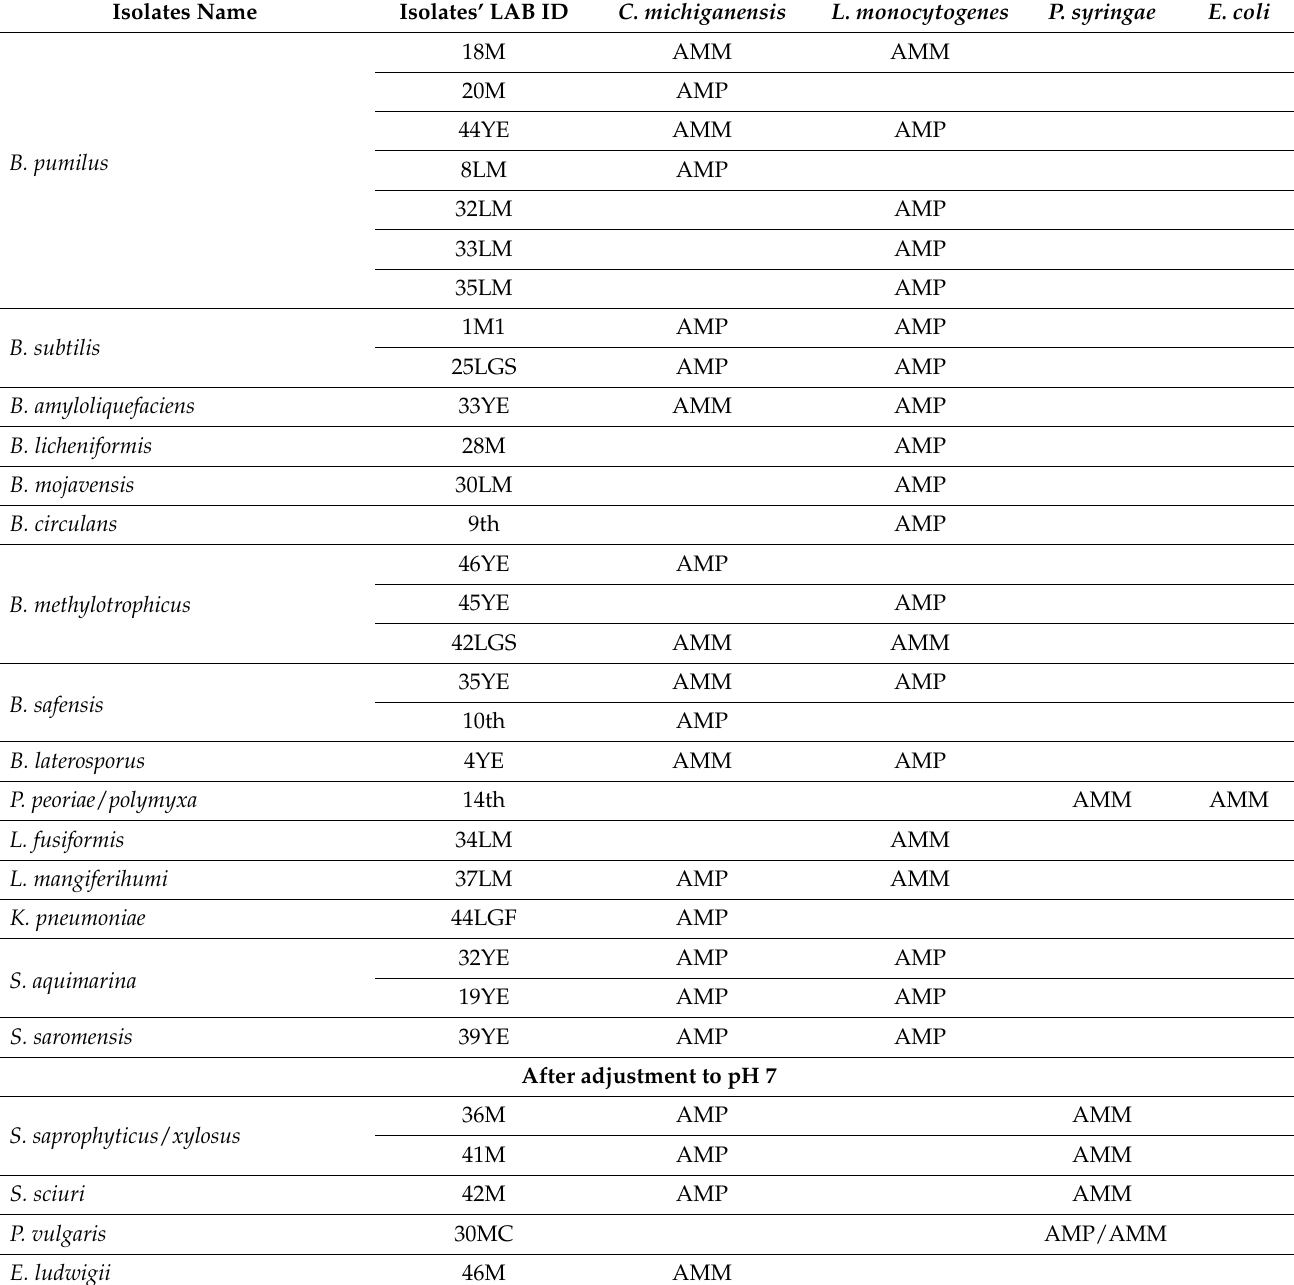
Table 1. Bacterial isolates from this study with inducible antimicrobial